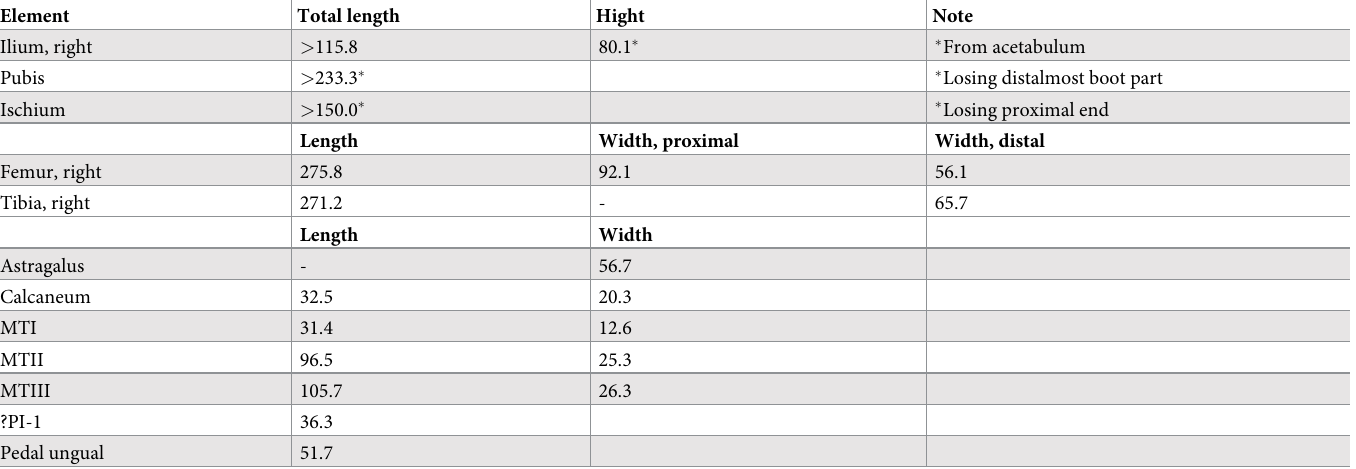
Table 3. Measurements in millimeters of pelvic girdle and hindlimb elements of B . inexpectus (IVPP V 11559).